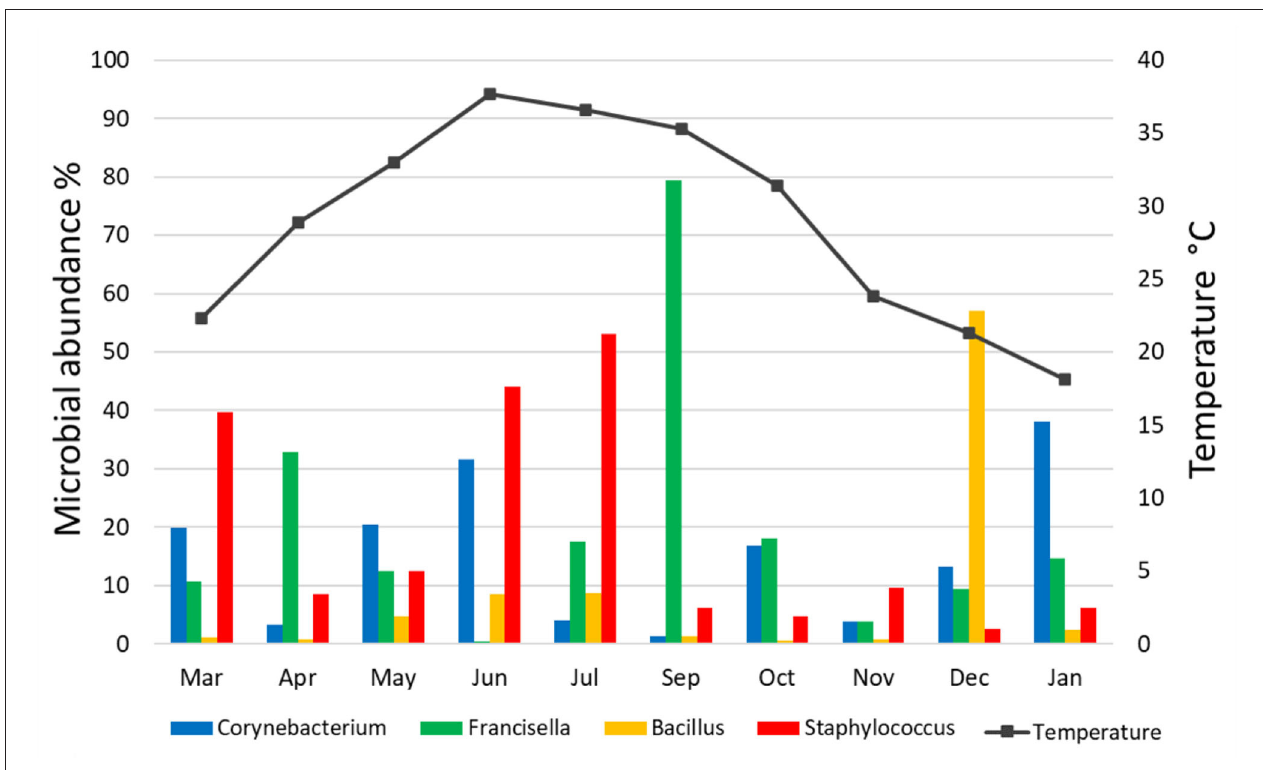
FIGURE 7 | Variation in the relative abundance of bacterial genera in relation to temperature in H. dromedarii partially engorged female ticks throughout the